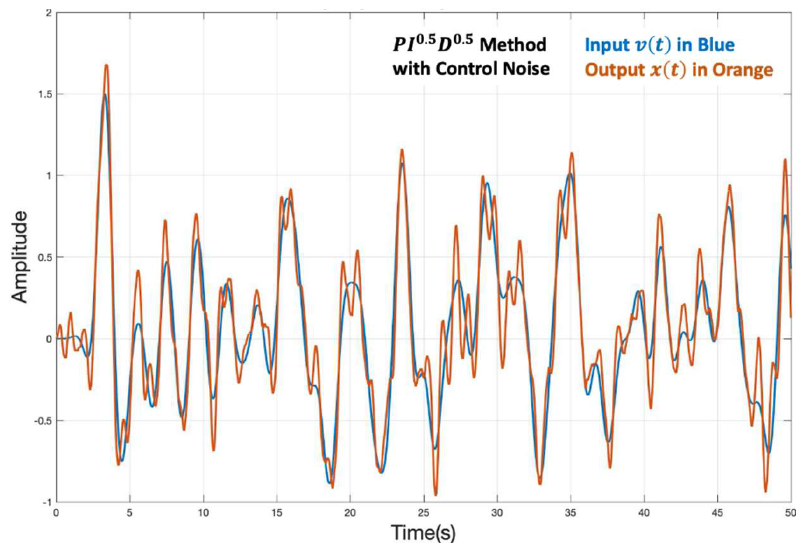
Figure 22. Impact of Noise on Control Performance (Technique 4).